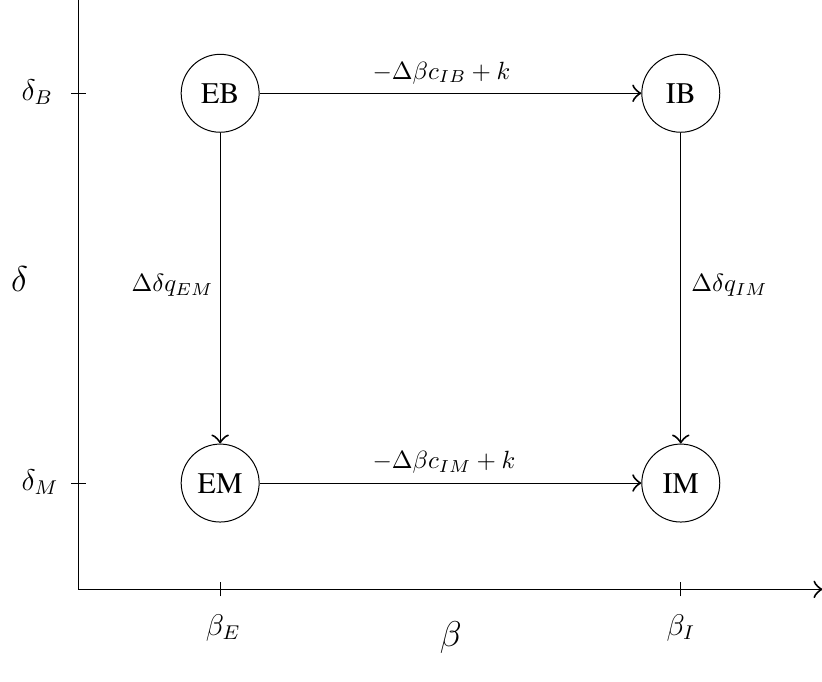
Figure 3. Incentive constraints that are binding in Case